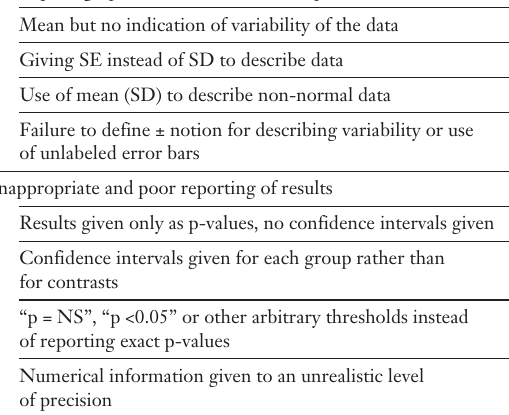
Statistical errors and deficiencies related to the presentation of study